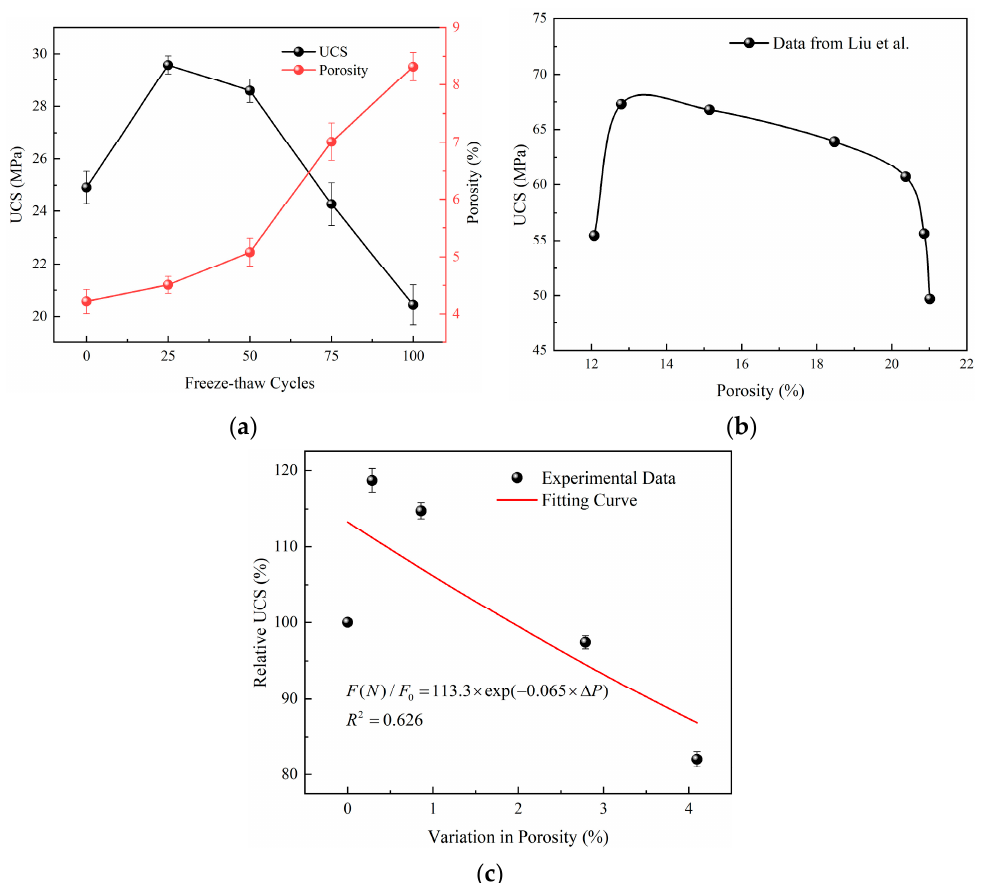
Figure 7. Relationship between UCS and porosity. ( a ) Variation of UCS and porosity with freeze-thaw cycles, ( b ) Research results of Liu et al. [36], ( c ) Fitting result of the deterioration model proposed by Gao et al. [35].